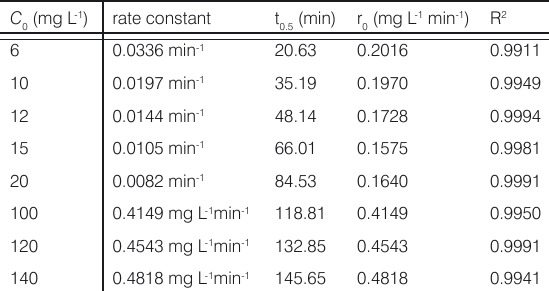
Figure 4. Plot of photocatalytic decolorization of MO vs. irradiation time. Table 1. Kinetic parameter for different initial concentration.